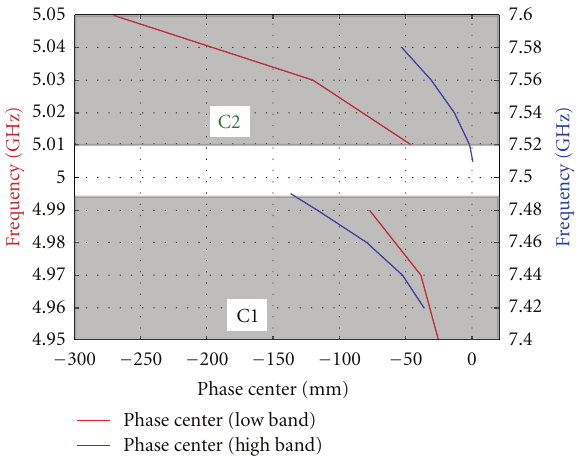
Figure 22: The phase center position for multifeed EBG dual-band antenna connected to used filters.